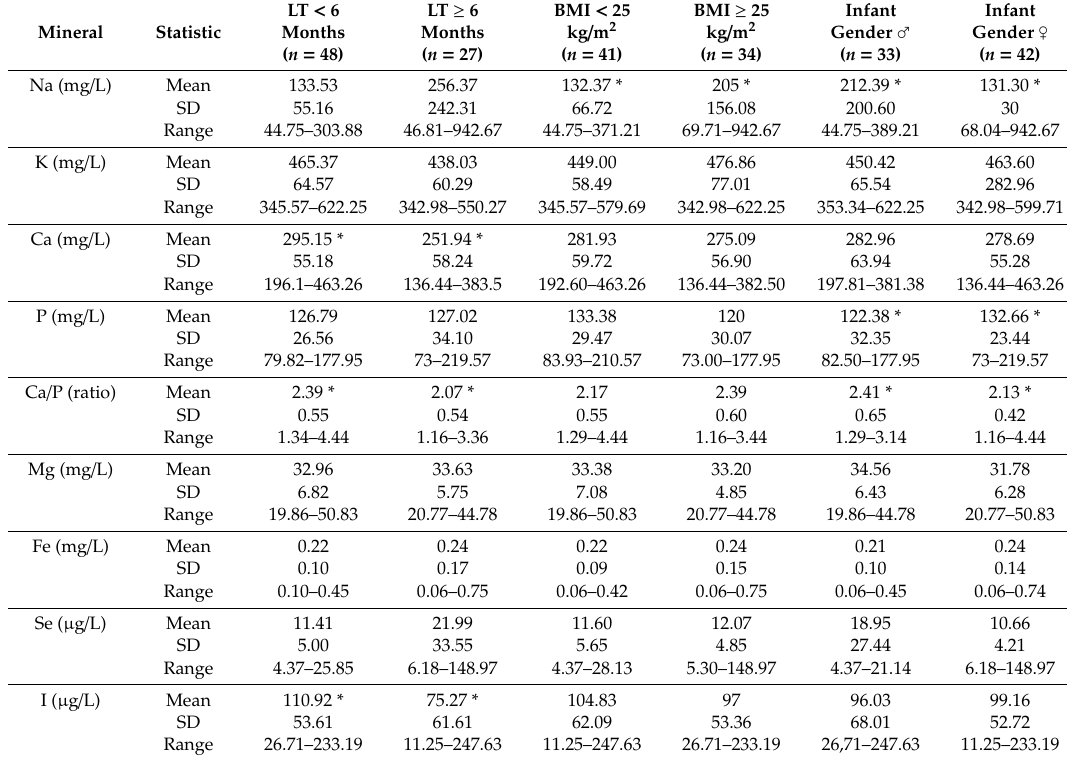
Table 6. Sodium, potassium, calcium, magnesium, phosphorus, iron, selenium and iodine content in breast milk, as well Ca / P ratio, presented as mean, standard deviation and range across di ff erent groups of samples (lactating time or LT, BMI, newborn